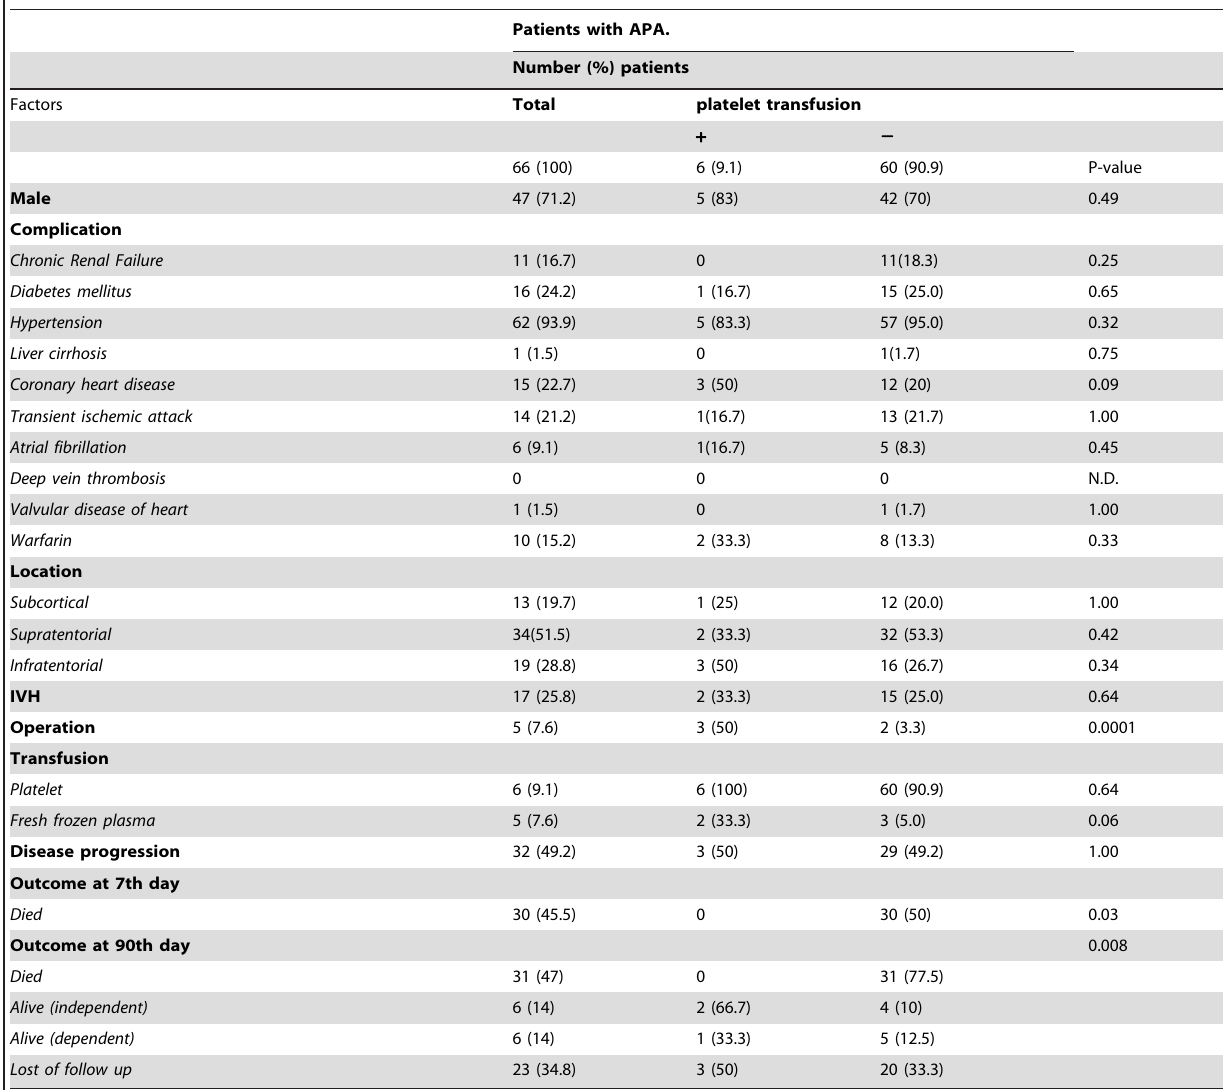
Table 4. Patient demographics and background characteristics.